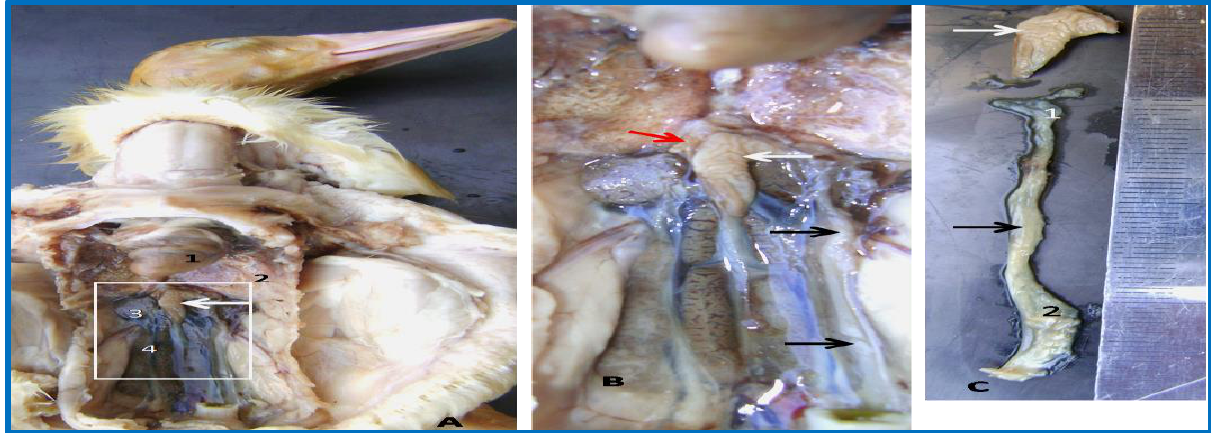
Figure, 1: Gross appearance at 4 weeks duckling body (Mallard duck) shows: A. Heart (1), lung (2), cranial division of right kidney (3), middle division of right kidney (4), ovary (White arrow), B. The magnification of white rectangle area in figure (A) shows left ovary (white arrow), right ovary (red arrow), and oviduct (Black arrow), C. The ovary (White arrow) and the left oviduct (Black arrow) which consisted of cranial end (1), caudal end